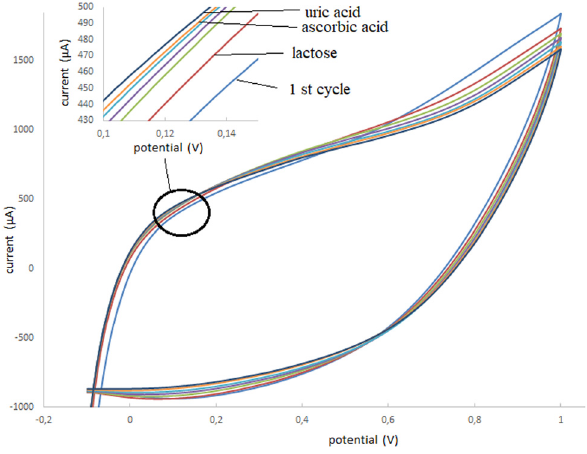
Figure 11: E ff ect of interferents on the response of lactose biosensor at + 0.12 V in the range of − 0.1 to 1.0 V applied potential, pH 6.7.